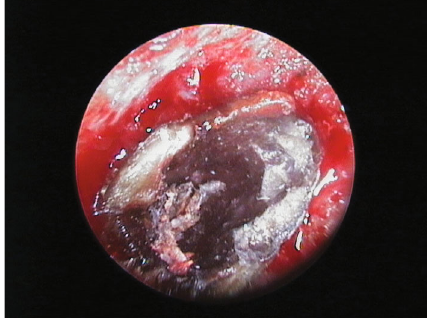
Figure 12: Endoscopic view of 2.1 after removal of the old fi ller material and checking of retrograde cavity integrity.